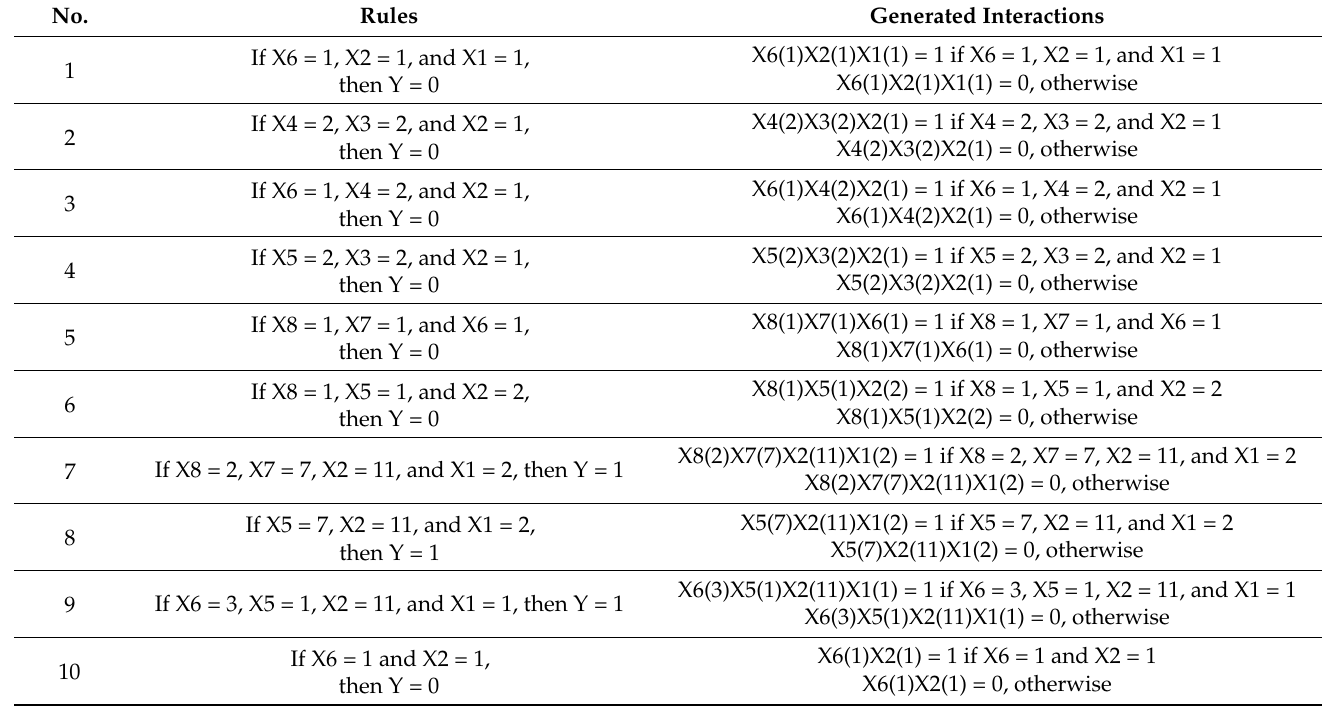
Table 6. First 10 classifier rules generated by CBA: diabetes